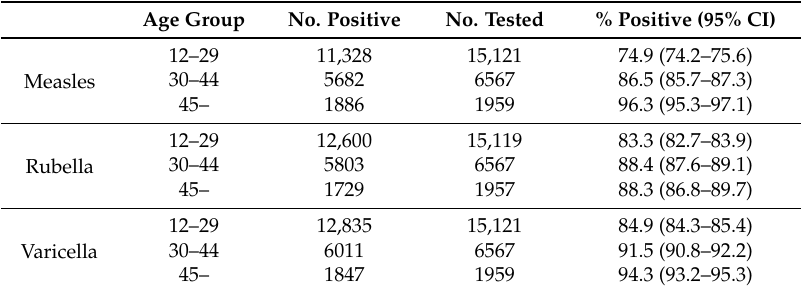
Table 3. Number of positive and tested samples and seroprevalence with 95% confidence intervals for measles, rubella and varicella antibodies stratified by age